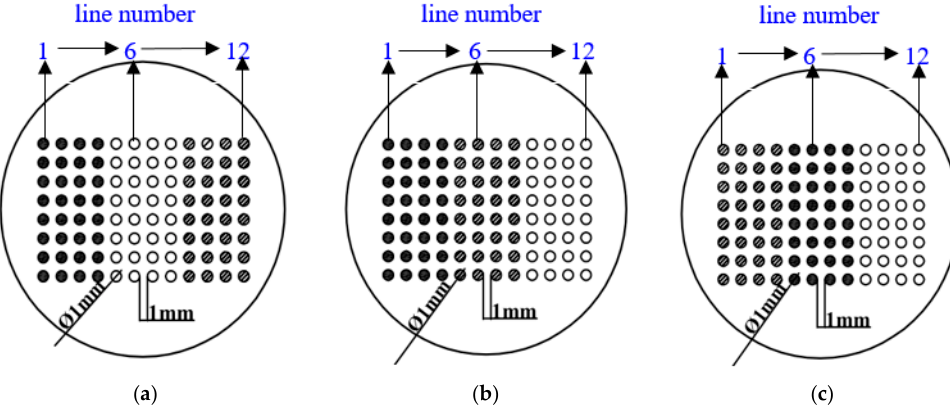
Figure 2. Schematics of three CMEAs with different metal arrangement sequences: ( a ) CMEA1 (HAl77-2/316L SS/TA2); ( b ) CMEA2 (HAl77-2/TA2/316L SS); ( c ) CMEA3 (TA2/HAl77-2/316L SS). ( ●